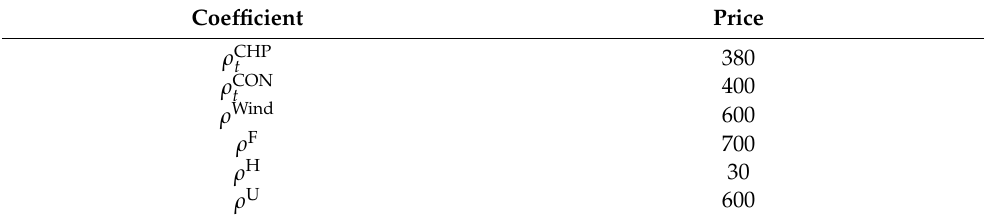
Table 3. Electricity price of the Internet, coal price, and price of the heat sold.